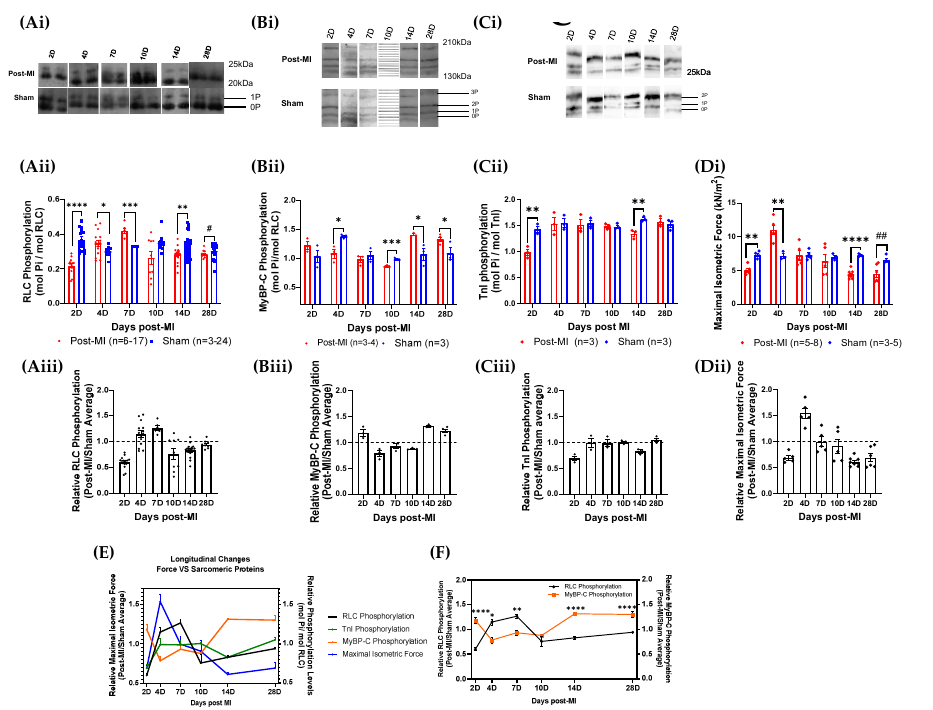
Figure 4. Longitudinal sarcomeric protein phosphorylation and maximal isometric force measure- ments during HF progression. ( Ai , Bi , Ci ) Blot images of RLC, MyBP-C and TnI phosphorylation levels of post-MI and sham groups at different time points ranging between 2D and 28D post-MI, respectively. ( Aii , Bii , Cii , Di ) Bar graphs of RLC, MyBP-C and TnI phosphorylation and maximal isometric force of post-MI and sham groups at different time points ranging between 2D and 28D post-MI. Unpaired one-tailed t -test (*) was conducted on parametric and homogenous population. Unpaired one-tailed t-test with Welch’s correction (*) was conducted on parametric but inhomoge- neous population. Unpaired one-tailed Mann–Whitney test ( # ) was conducted on non-parametric population. Number of mice used is summarised in Table S1. Note: ‘ n ’ refers to the number of techni- cal replicates. ( Aiii , Biii , Ciii , Dii ) Bar graphs for relative RLC, MyBP-C and TnI phosphorylation and maximal isometric force values during HF progression, respectively. Kruskal-Wallis ANOVA test was performed on RLC phosphorylation populations and showed that the medians varied signifi- cantly (* p = 0.0102). Ordinary one-way ANOVA performed on MyBP-C phosphorylation showed significant differences in the means (**** p < 0.0001). Ordinary one-way ANOVA performed on TnI phosphorylation showed significant differences in the means (** p < 0.01). Ordinary one-way ANOVA performed on isometric force data showed significant difference among population means ( p < 0.0001). ( E ) Line graph of relative phosphorylation levels of all three sarcomeric proteins and isometric force. ( F ) Line graph of relative phosphorylation levels of RLC and MyBP-C. Note: * p < 0.05, ** p < 0.01, *** p ≤ 0.001, **** p < 0.0001, # p < 0.05, ## p <